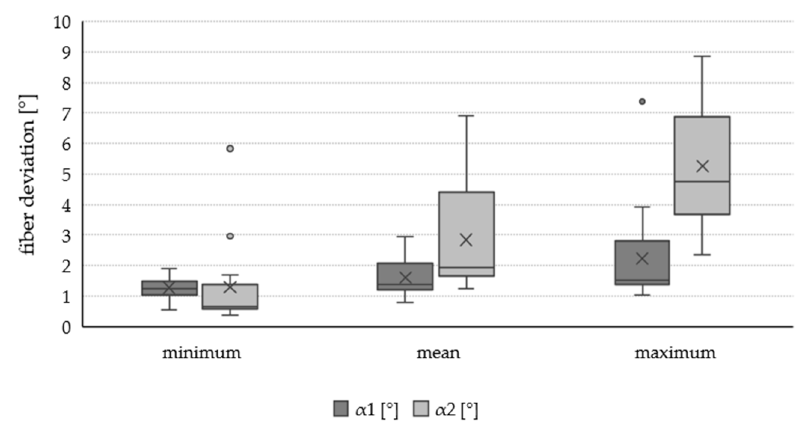
Figure 4. Minimum, mean and maximum fiber deviation in- and out-of-plane of n = 18 samples. The mean value is an average of seven measurements within one sample. Minimum and maximum are lowest and highest recorded value of one sample respectively.